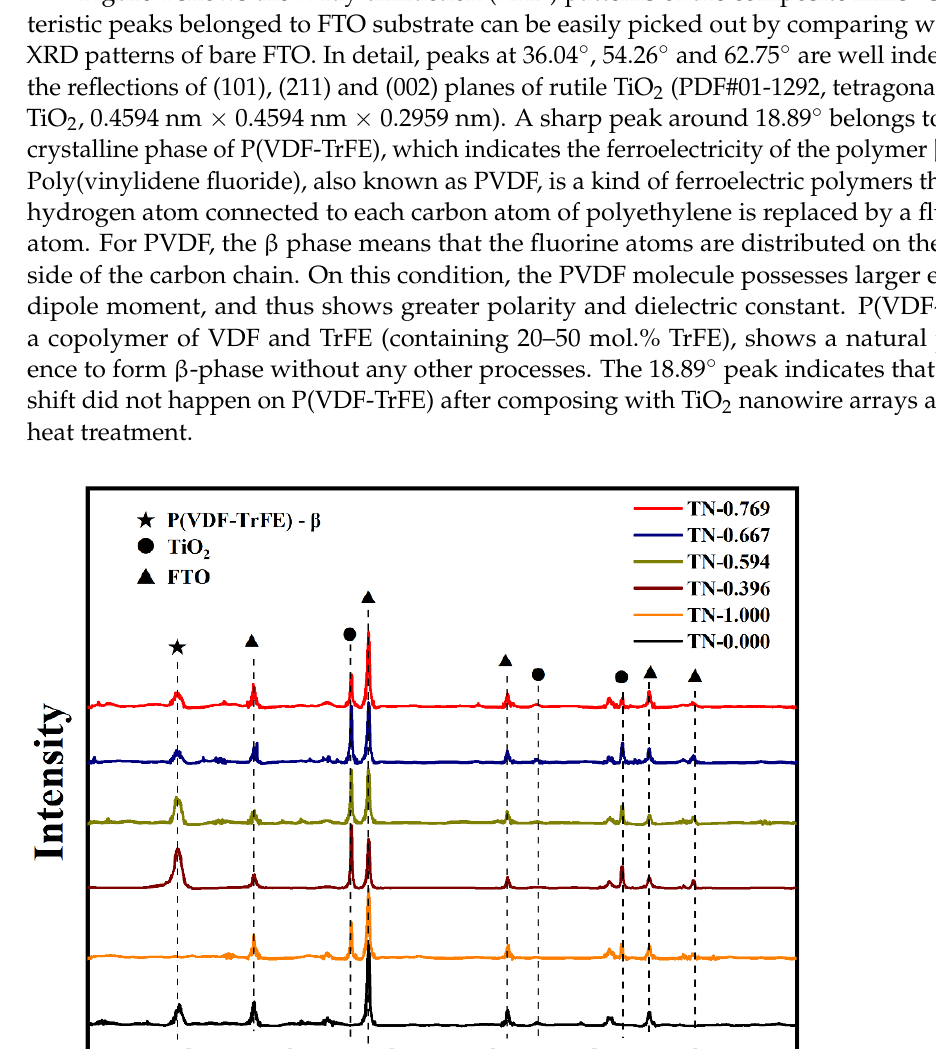
Figure 5. FTIR patterns of composite TN0.769, TN-0.667, TN-0.594, TN-0.396 and TN-0.000.